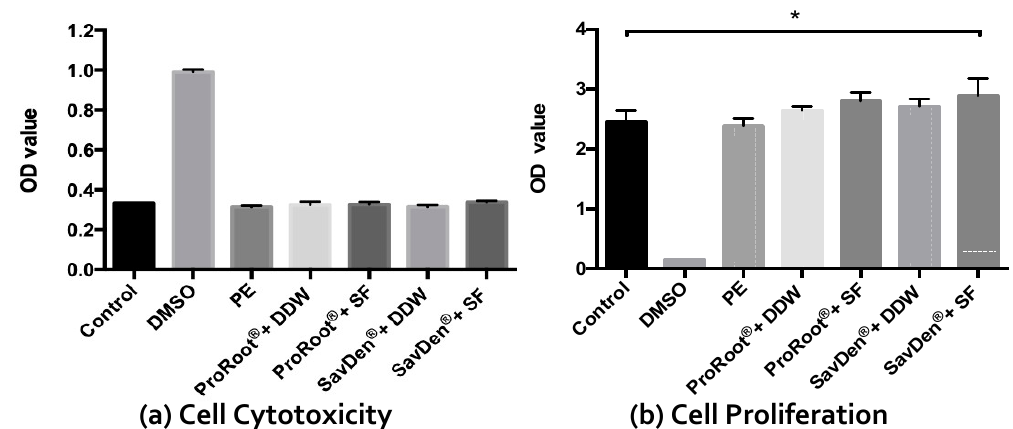
Figure 3. MG-63 osteoblast-like ( a ) cell cytotoxicity and ( b ) cell proliferation of ProRoot ® white MTA and SavDen ® MTA individually set with deionized water (DDW) and 5 wt% SF solution. Three samples (n=3) were examined for each data point. * Indicates a significant difference (P<.05).